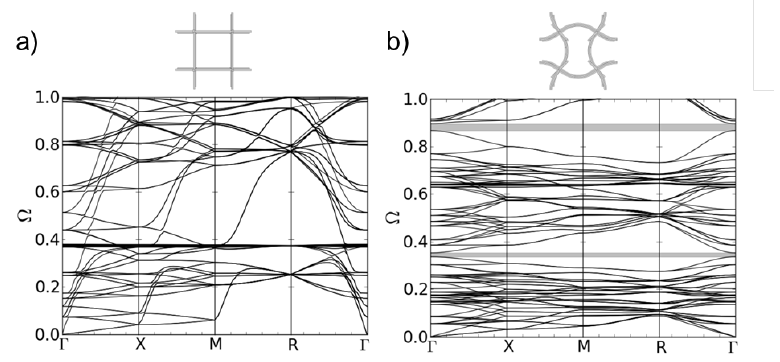
Figure 7. Dispersion relations of structure ( a ) a-3D (l = 5.0 mm, d = 0.25 mm); and ( b ) b-3D (l = 5.0 mm, A = 1.0 mm, d = 0.25 mm).